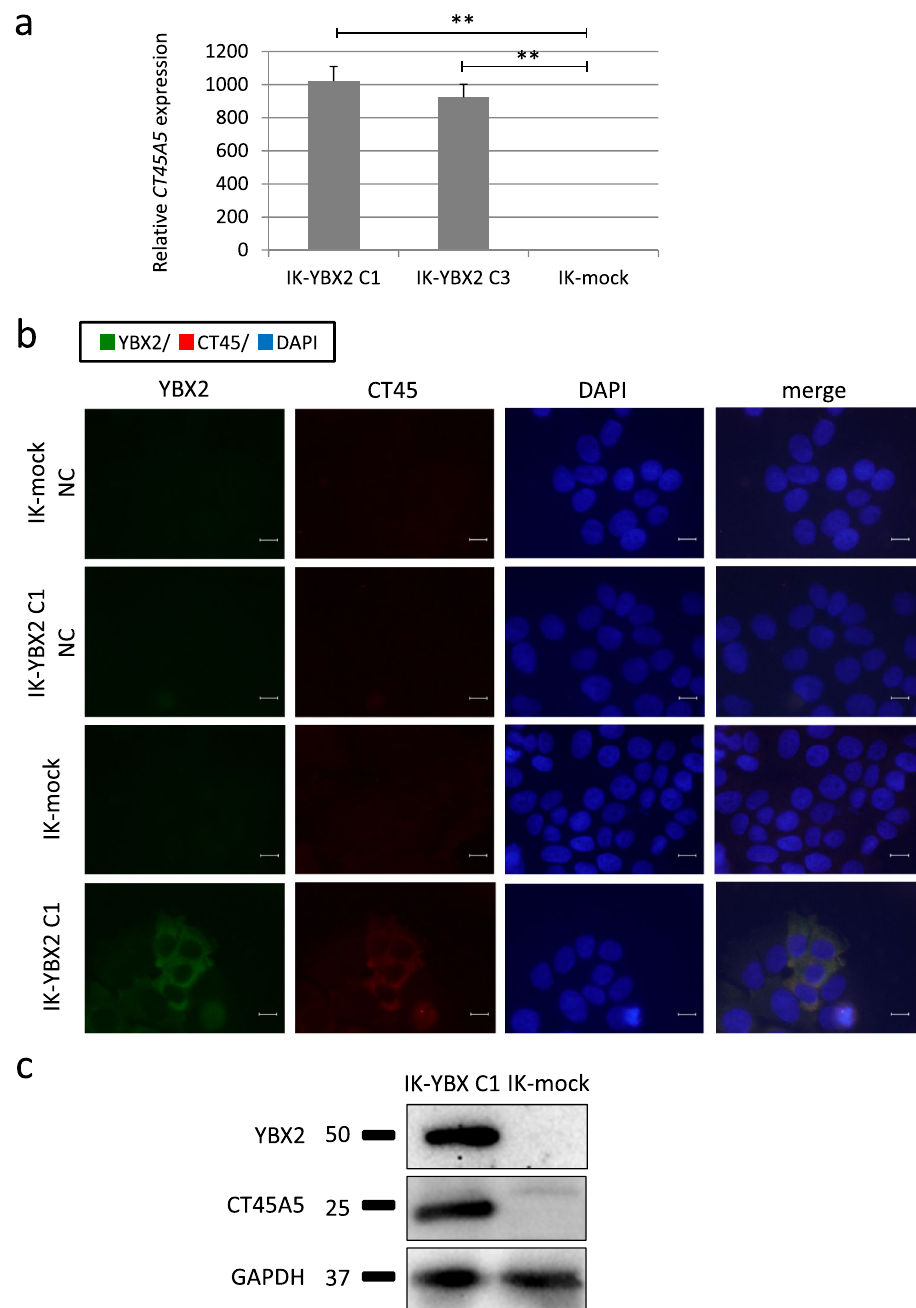
Figure 3. The levels of CT45A5 gene and protein expression were significantly increased in IK-YBX2 cells compared with those in mock cells. ( a ) The level of CT45A5 expressed in IK-YBX2 cells (C1 and C3) was increased more than 900-fold compared with that in mock cells. GAPDH was used as internal control. Data represent the means ± SD from three independent experiments. (** p < 0.01). ( b ) YBX2 and CT45 expression levels in IK-YBX2 C1 cells were detected by fluorescence microscopy. Co-expression of YBX2 and CT45 in the cytoplasm of IK-YBX2 C1 cells was observed. Scale bars: 10 µm. ( c ) The levels of both proteins of YBX2 and CT45 were markedly increased in IK-YBX2 C1 cells and compared with that in mock cells. Full length blots are shown in Supplementary Fig. S5c